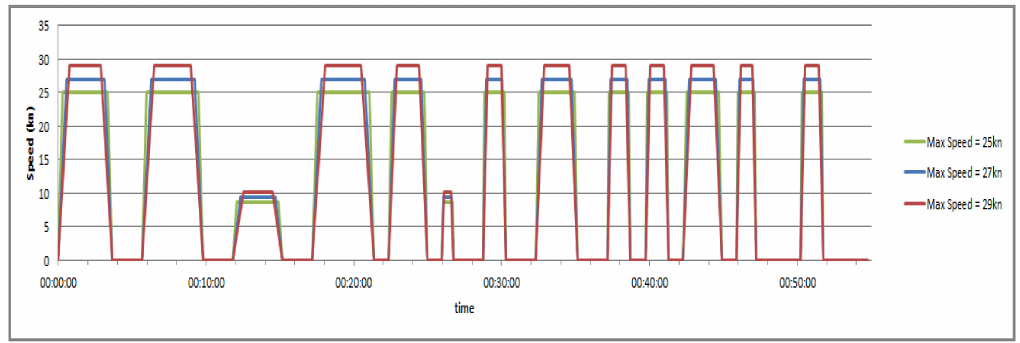
Figure 1. Image of the Stavanger Demonstrator and planned TrAM project replication studies for Figure 3. Typical operational speed profile for a prespecified number of port calls and travel plan [20]. zero-emission, urban waterborne transport [10] https://tramproject.eu/.